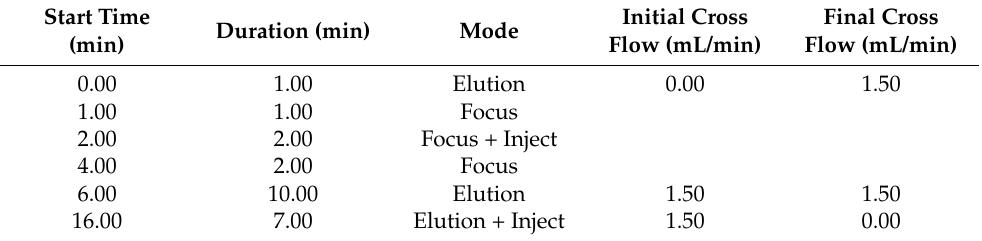
Table 6. AF4 method used to characterize